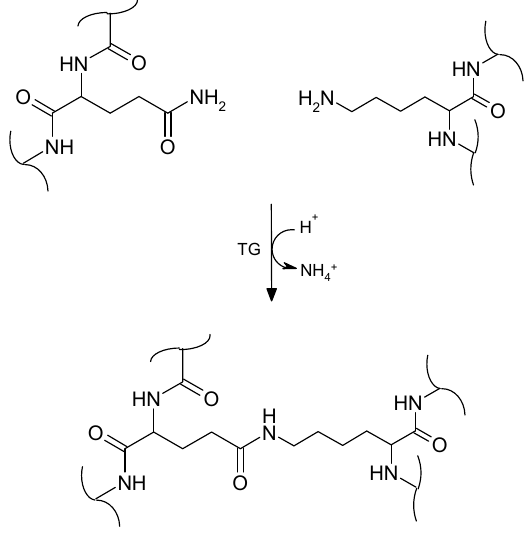
Figure 4. Reaction mechanism of mTG: formation of covalent ε -( γ -glutamyl-)lysine bonds.